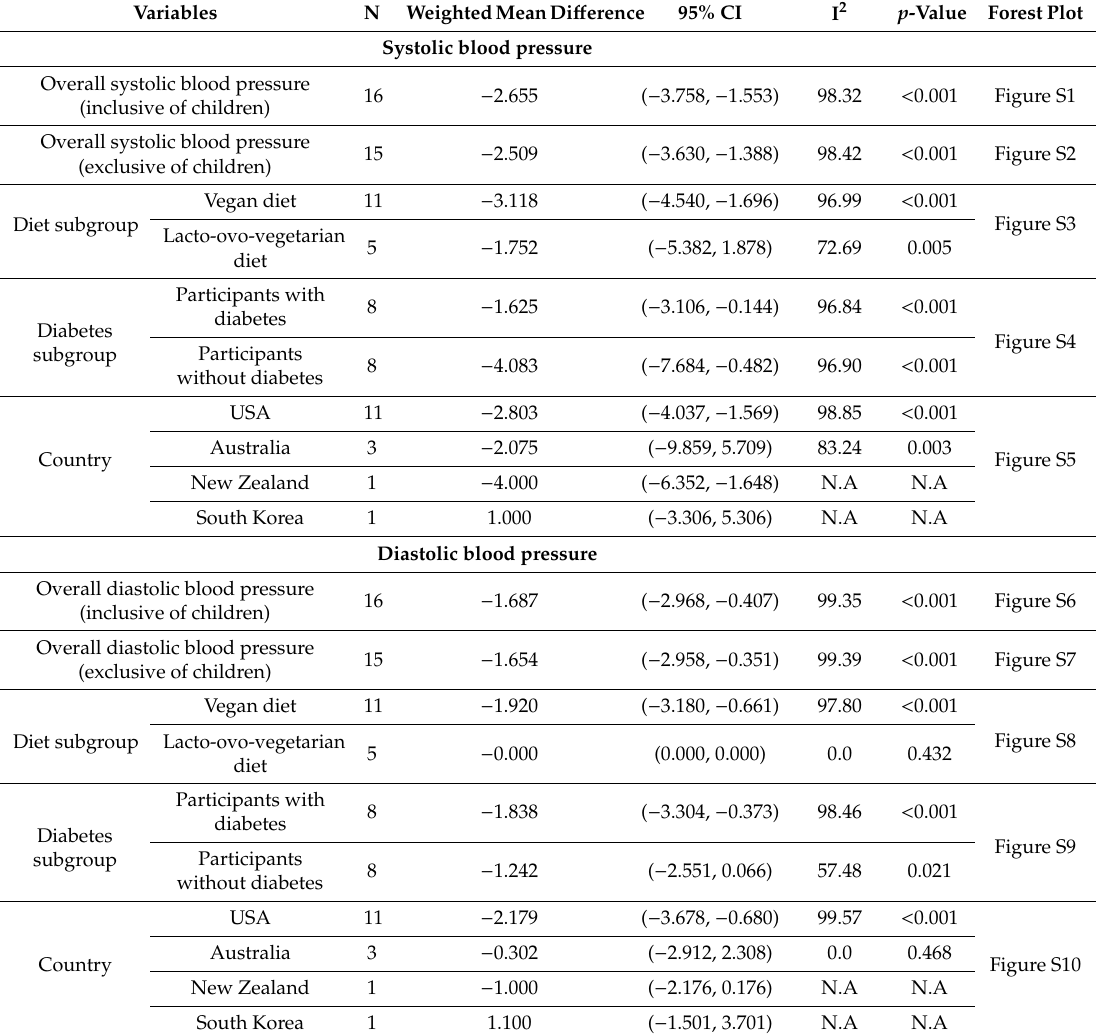
Table 2. Weighted mean di ff erence and 95% confidence interval of blood pressure by subgroup